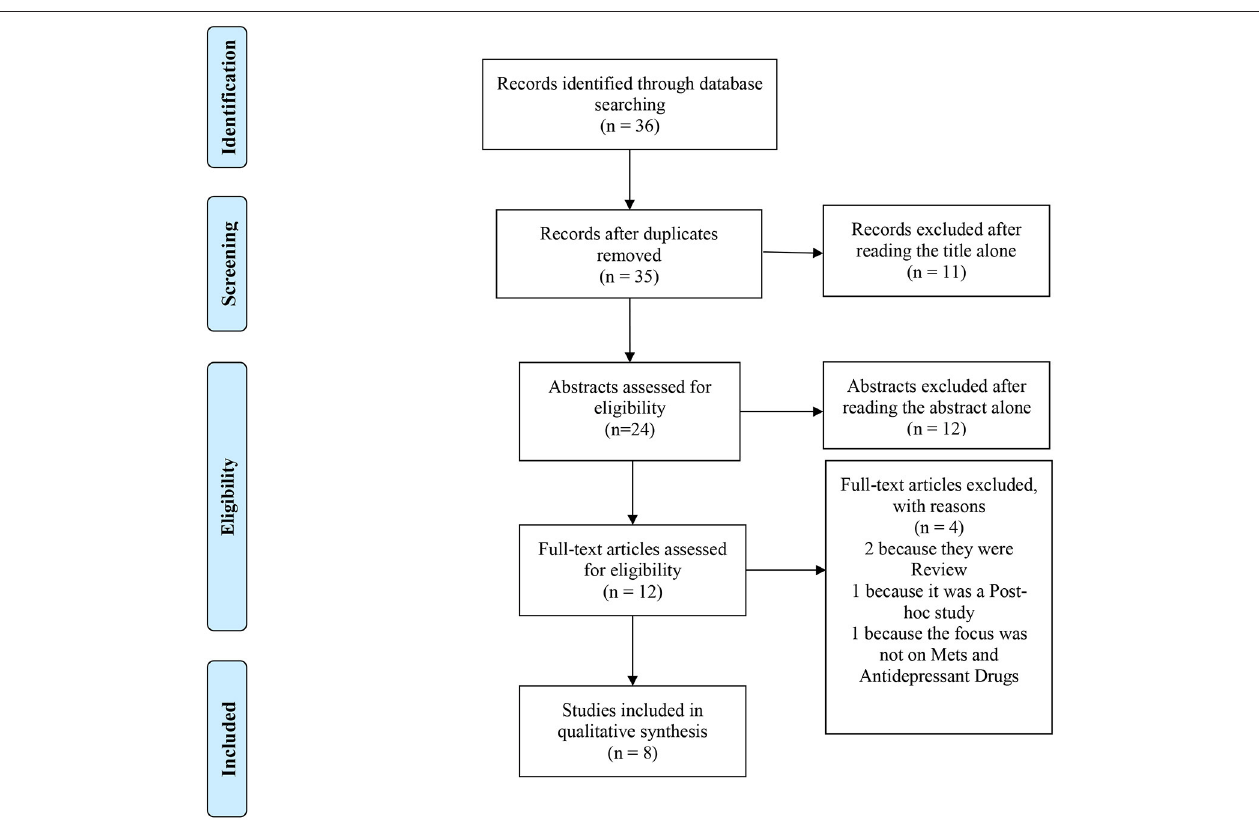
FIGURE 1 | PRISMA 2009 flow diagram. Adapted from Moher et al.